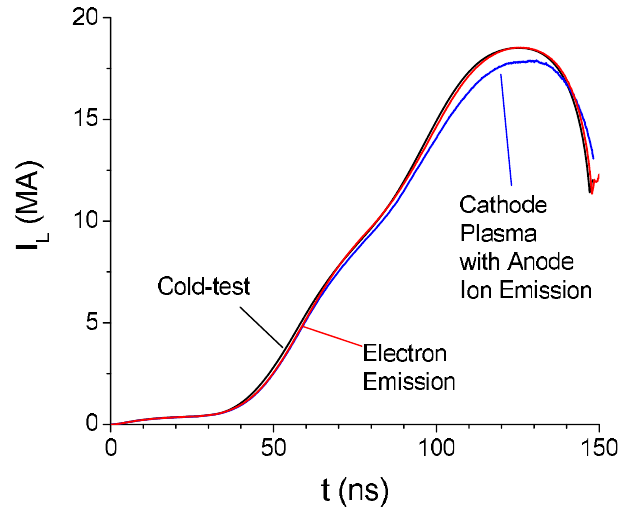
FIG. 3. (Color) Comparison of the simulated load currents as a function of time. The black curve represents the cold-test result, the red curve represents a simulation with electron emission from the cathode surfaces. The blue curve is the load current from a simulation that includes cathode plasma injection ( D (cid:4) 0 : 0075 ml = ns ) and ion emission from the posts (case